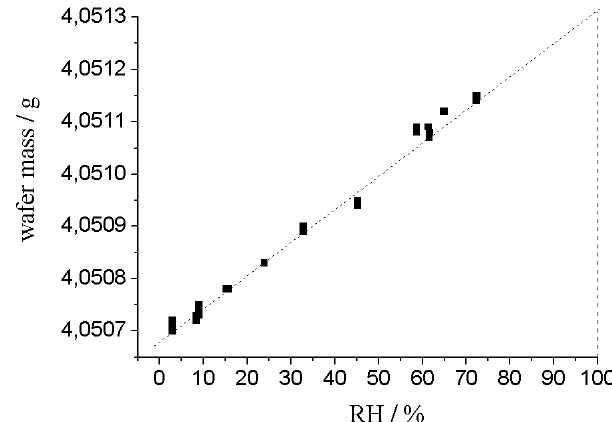
Figure 5. Relation between relative humidity and wafer mass. At 100%RH, the wafer mass and the saturation concentration c s (Eq. 1) reach the maximum. By averaging the results from four wafers, we found that the maximum loading capacity c s,max of Durimide 7505 was 3.2%.